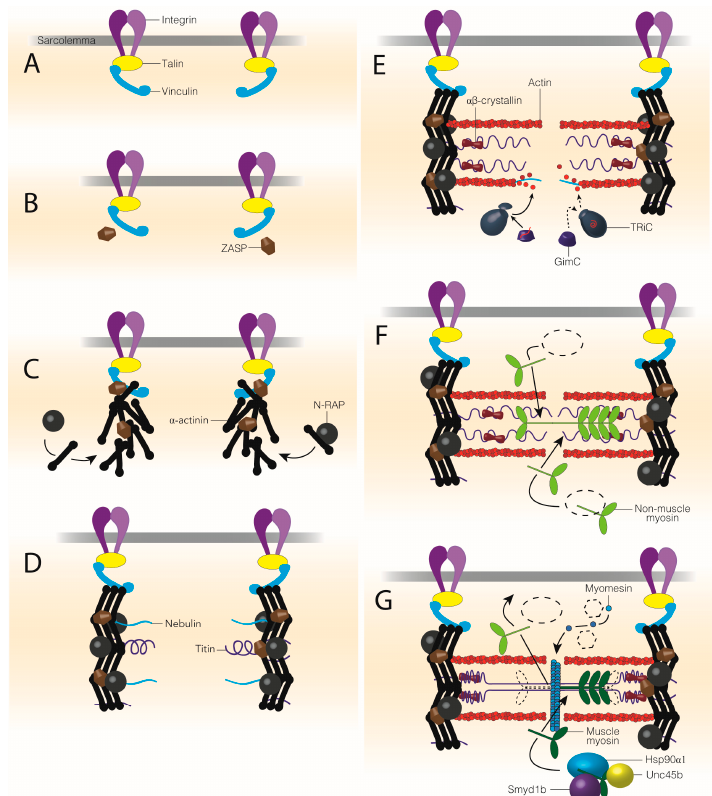
Figure 3. The Premyofibril Model of Sarcomere Assembly and Necessary Chaperones. Sarcomere assembly begins with the dimerization of integrins in the sarcolemma. Integrins recruit talin